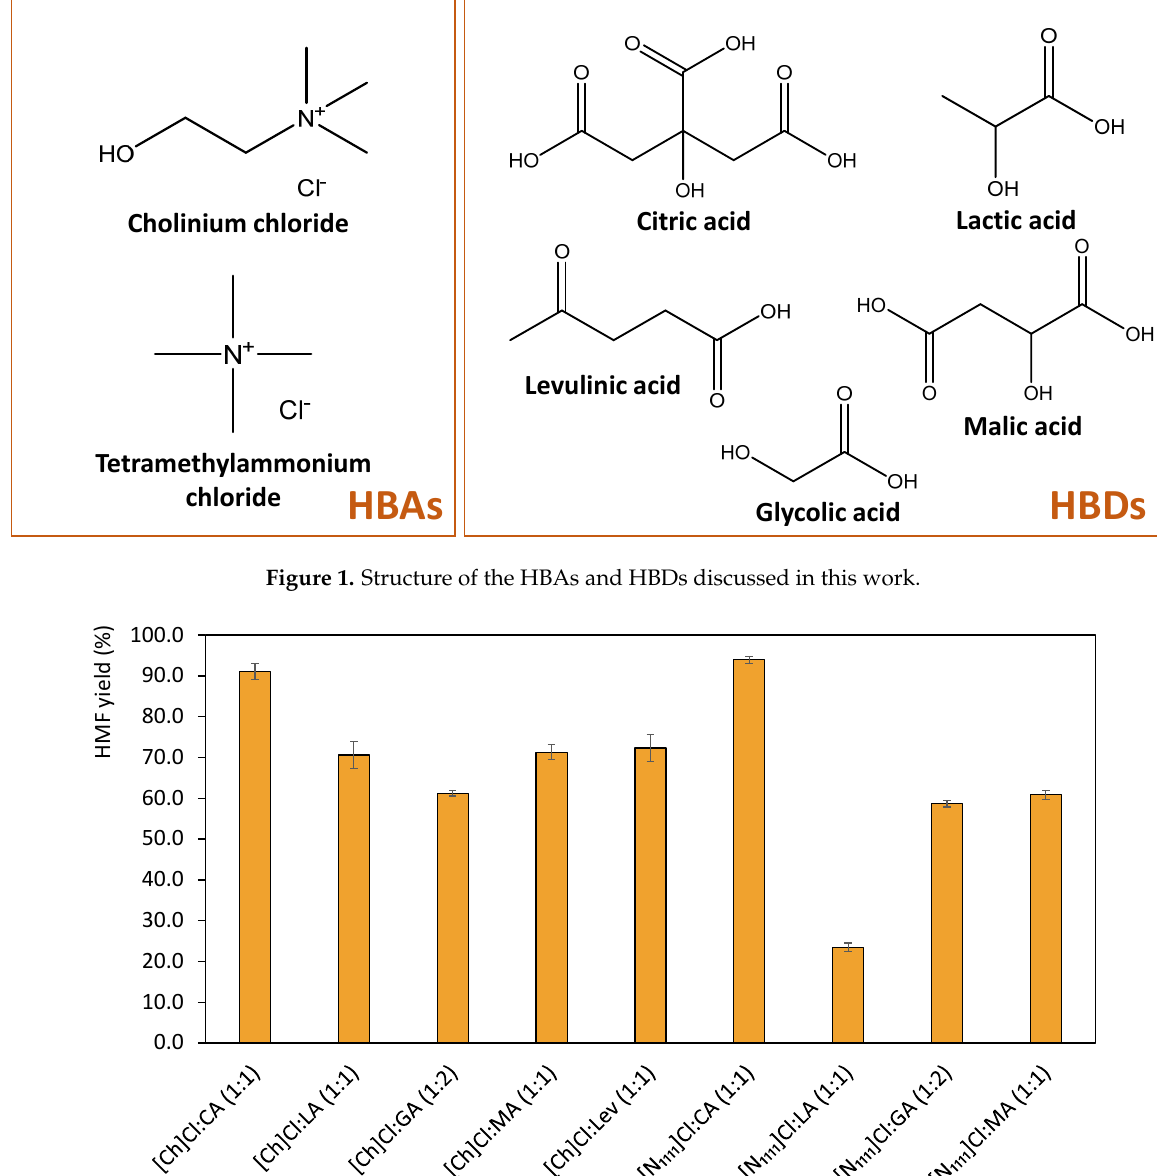
Figure 1. Structure of the HBAs and HBDs discussed in this work.